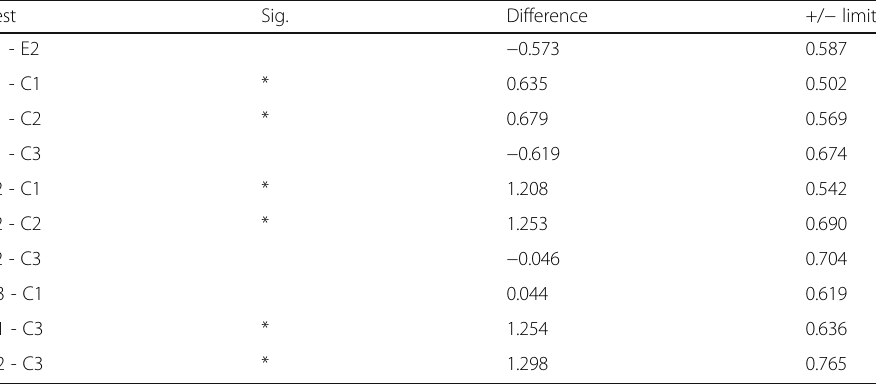
Table 2 Multiple comparison test (Fisher ’ s LSD method) of mean level of written production (pre-treatment) in the 5 subgroups (C1, C2, C3, E1 and E2) Test Sig. Difference +/ − limits E1 - E2 − 0.573 0.587 E1 - C1 * 0.635 0.502 E1 - C2 * 0.679 0.569 E1 - C3 − 0.619 0.674 E2 - C1 * 1.208 0.542 E2 - C2 * 1.253 0.690 E2 - C3 − 0.046 0.704 C3 - C1 0.044 0.619 C1 - C3 * 1.254 0.636 C2 - C3 * 1.298